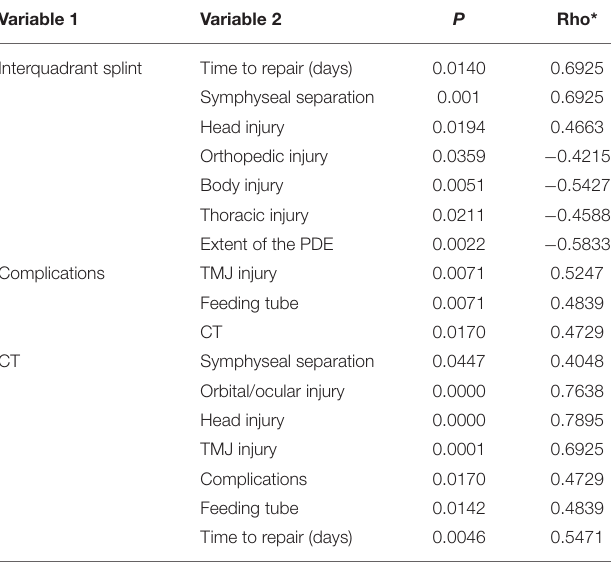
TABLE 4 | Correlation between independent variables (Spearman rank test, p < 0.05). Variable